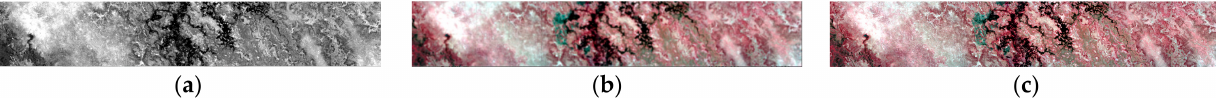
Figure 7. The Botswana dataset: ( a ) Panchromatic image, ( b ) RGB image of hyperspectral data and ( c ) RGB image of ground truth data.